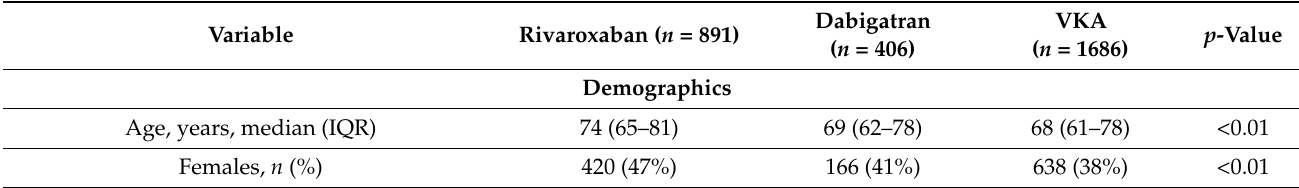
Table 2. Baseline